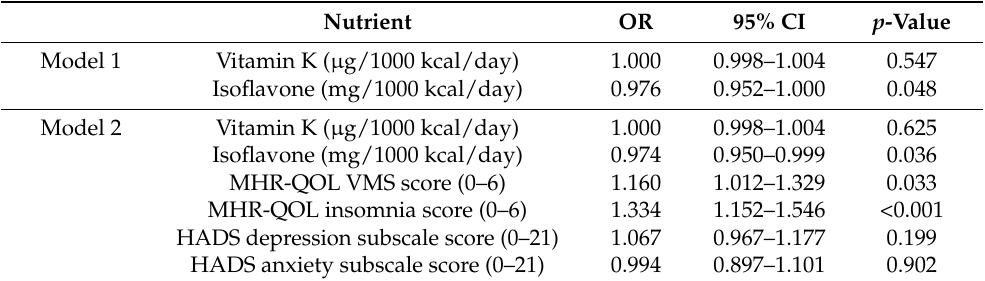
Table 3. Associations between the daily intake of isoflavone (mg/1000 kcal/day) and the frequency of headache.